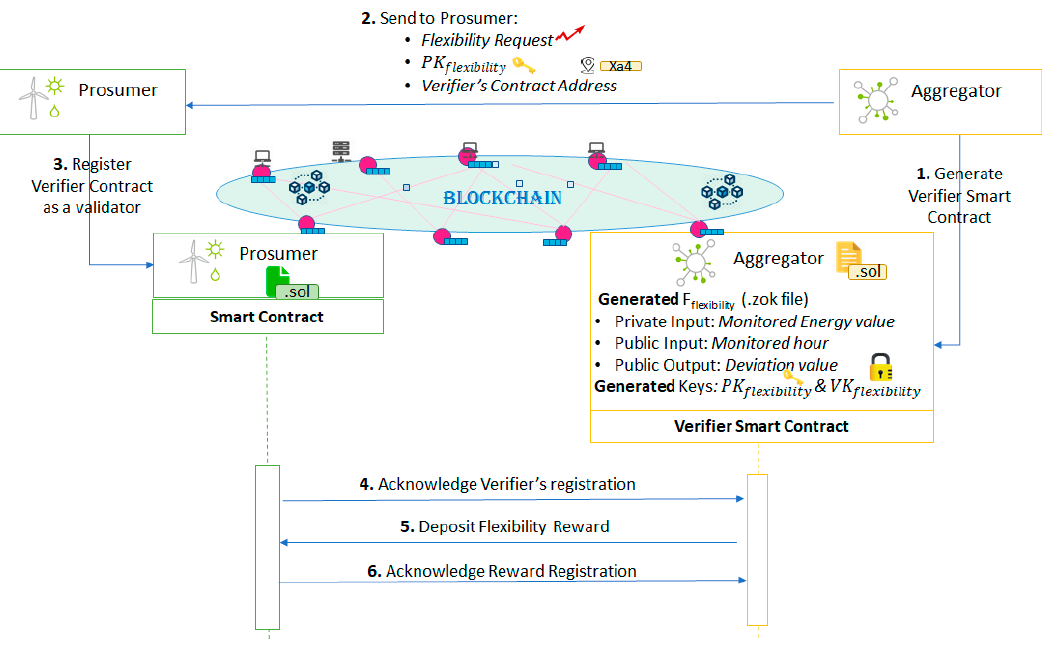
Figure 2. ZKP for enrolling prosumers in DR and assuring the privacy of data exchanged between aggregator and prosumers over blockchain.